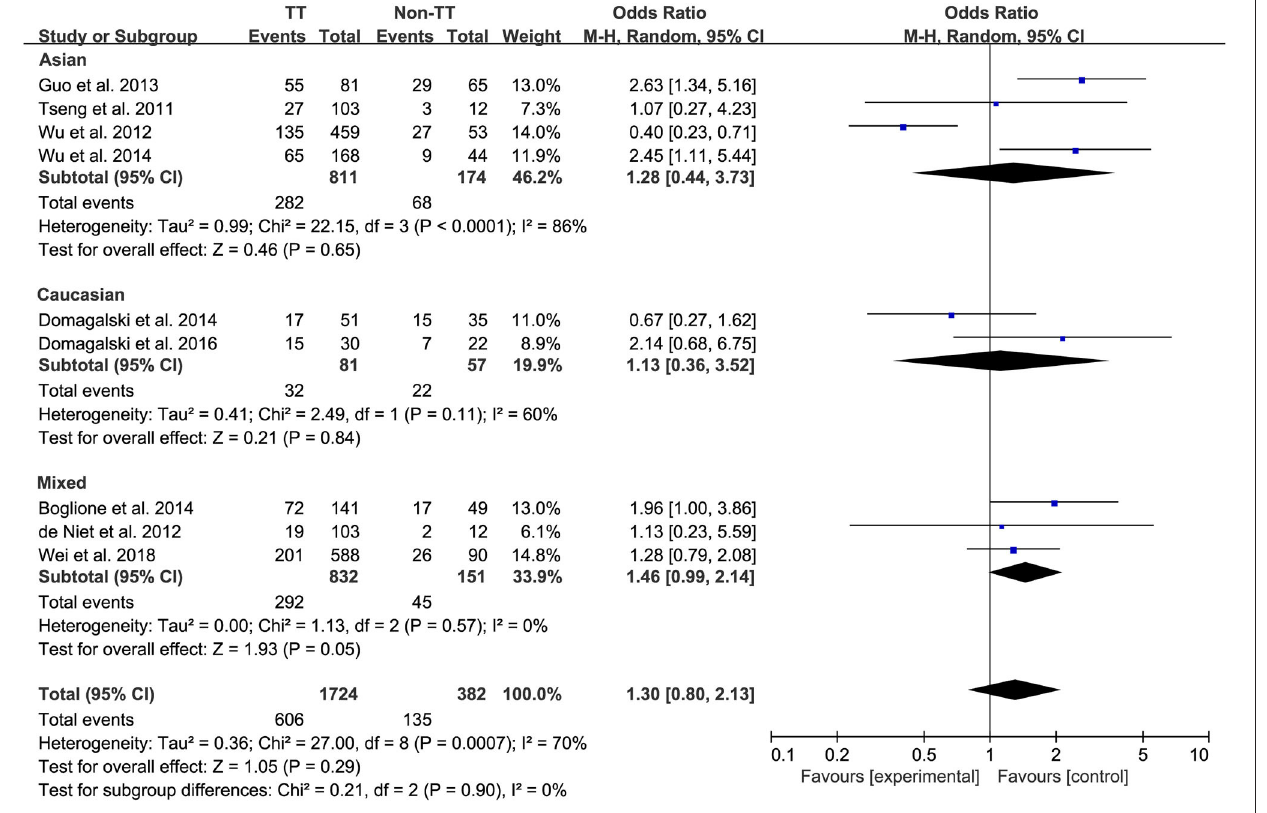
FIGURE 7 | Subgroup analysis of rs12979860, stratified by